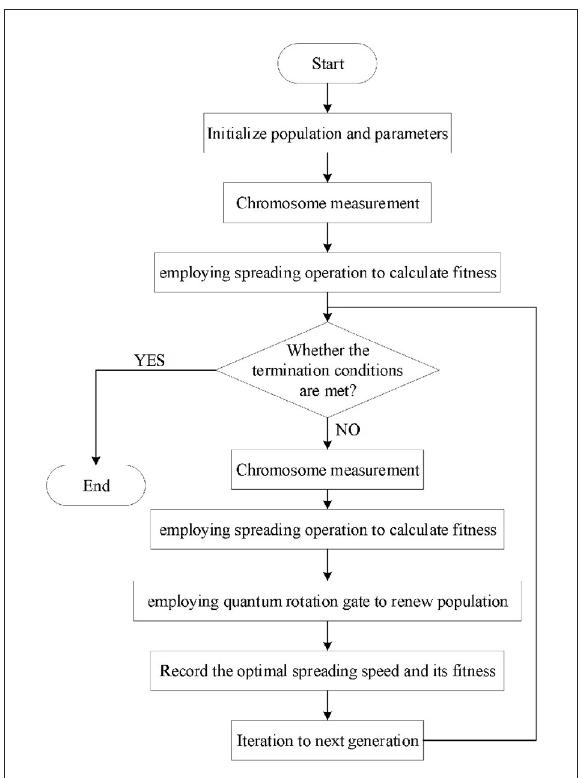
FIGURE6 The flow chart of IQGA, considering a spread operation.